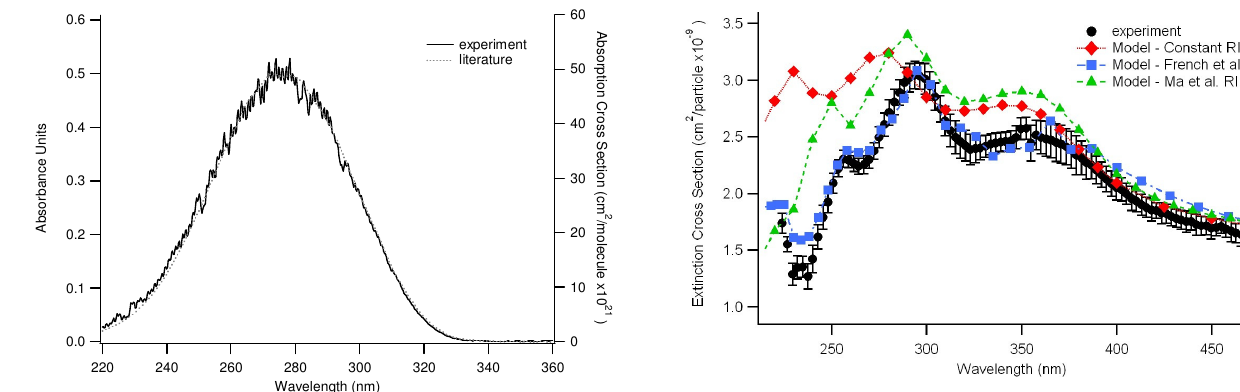
Figure 6. The UV absorption spectrum obtained with the AE-DOAS of acetone with a 5-point boxcar average is shown as a solid black line. This is compared with the dotted grey line showing the absorption cross section spectrum of gas phase acetone (shown on the right y-axis) (Meyrahn et al., 1986).